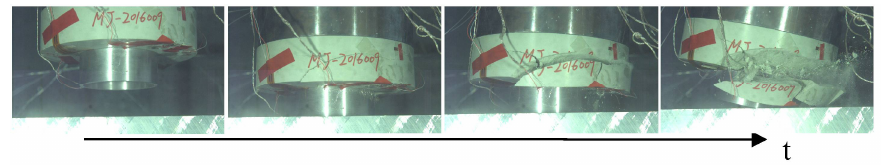
Figure 6. Drop test piece impact process.